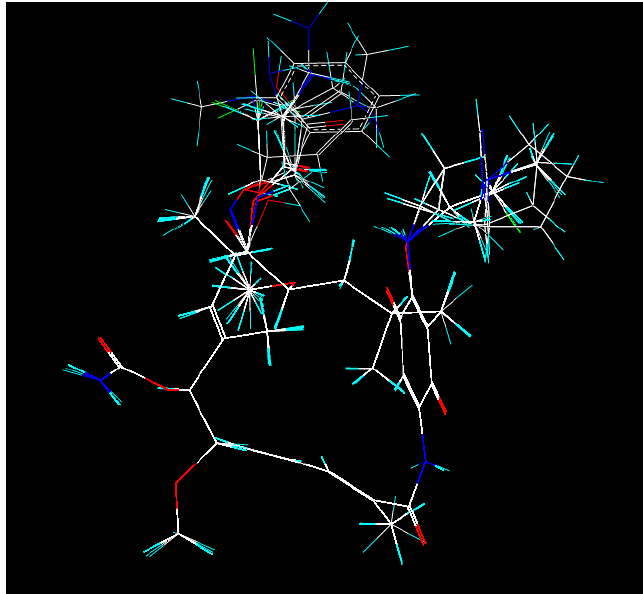
Figure 4. Alignment used to obtain 3DQSAR model A.